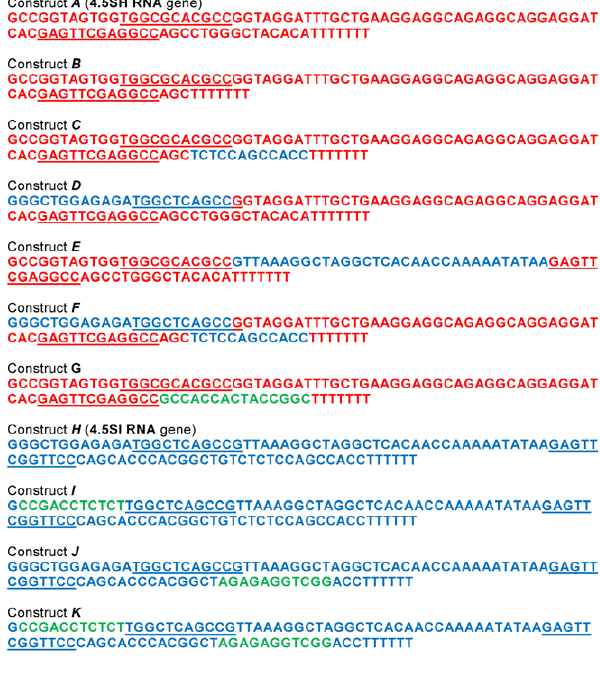
Figure 3. Nucleotide sequences of 4.5SH and 4.5SI RNA genes as well as their derivatives. Nucleotides of 4.5SH and 4.5SI RNA sequences are shown in red and blue, respectively. Green letters correspond to altered nucleotide sequences. Boxes A and B of the pol III promoter are underlined. T 6–7 at the end of constructs are the pol III terminator. (Fig. 6B,C). On the contrary, the sequence replacement of both ends (construct K ) recovered the complementarity and rendered RNA stable (Fig. 6A,B).